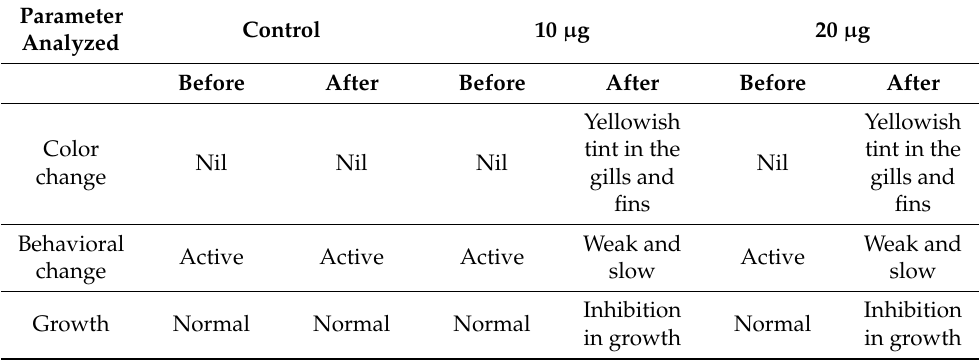
Table 3. Phenotypic changes observed in zebrafish exposed to silver nanoparticles synthesized using Bauhinia purpurea